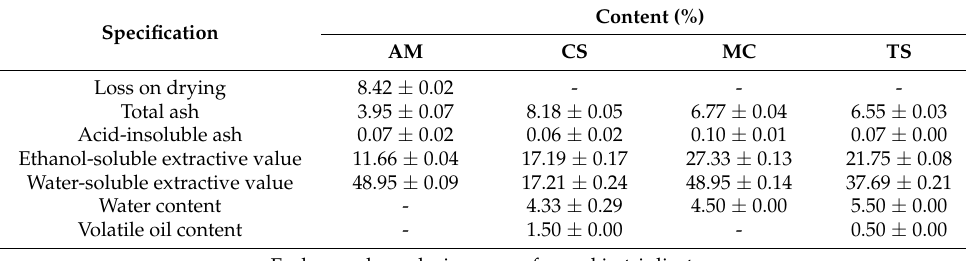
Table 1. Pharmacognostic characteristics of three fruit species and TS